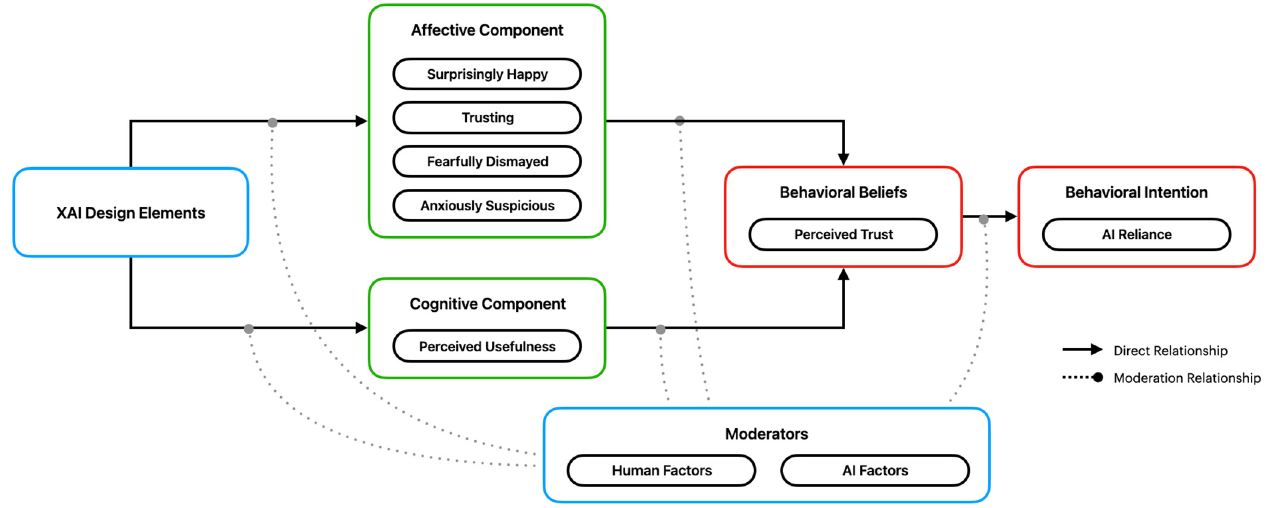
Figure 1. XAI Trust Calibration Model.